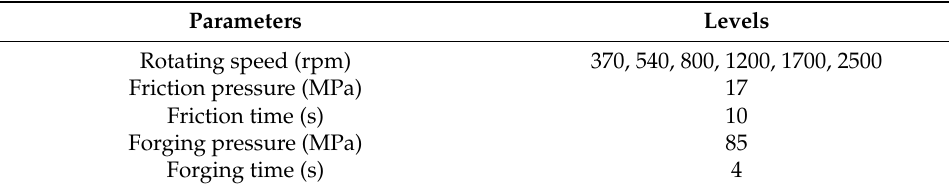
Figure 3. Rotary friction welding process stages. Table 3. Friction welding parameters.